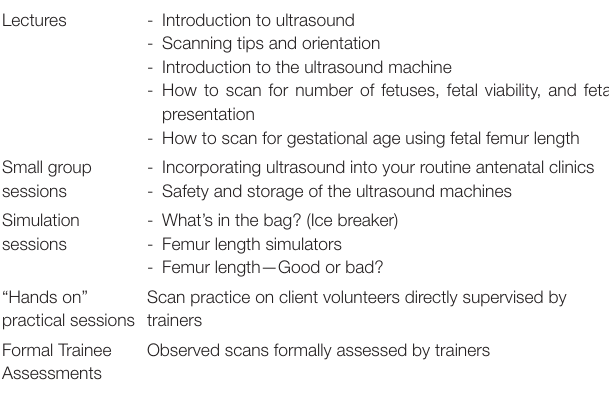
TABLE 1 | Components of ultrasound course. TABLE 2 | Components of